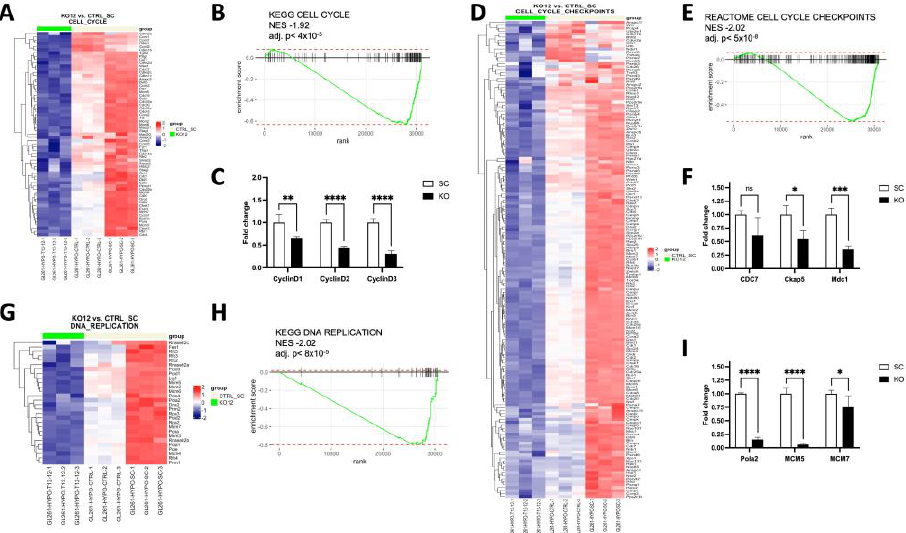
Figure 7. TCF12 loss globally affects critical cellular processes in tumor cells. ( A ) Heatmap showing differential expression of key genes in the cell cycle in TCF12 KO versus SC GL261 cells. ( B ) Repre- sentative KEGG enrichment plot for cell cycle genes showing global downregulation of some key regulators and effectors of the cell cycle. ( C ) qPCR data showing validation of the differential expression data for Cyclin D1, Cyclin D2, and Cyclin D3. ( D ) Heatmap showing differential expression of key genes in the cell cycle checkpoint. ( E ) Representative Reactome enrichment plot for cell cycle checkpoints showing global downregulation of key genes involved in cell cycle checkpoints. ( F ) qPCR data showing validation of the differential expression data for Ckap5, Mdc1, and Cdc7. ( G ) Heatmap showing differential expression of regulation of DNA replication. ( H ) Representative Reactome enrichment plot for DNA replication showing global downregulation of key genes involved in DNA replication. ( I ) qPCR data showing validation of the differential expression data for Pola2, Mcm5, and Mcm7. ns not significant; * p < 0.05, ** p < 0.01, *** p < 0.001, **** p < 0.0001 ( C , F , I ).